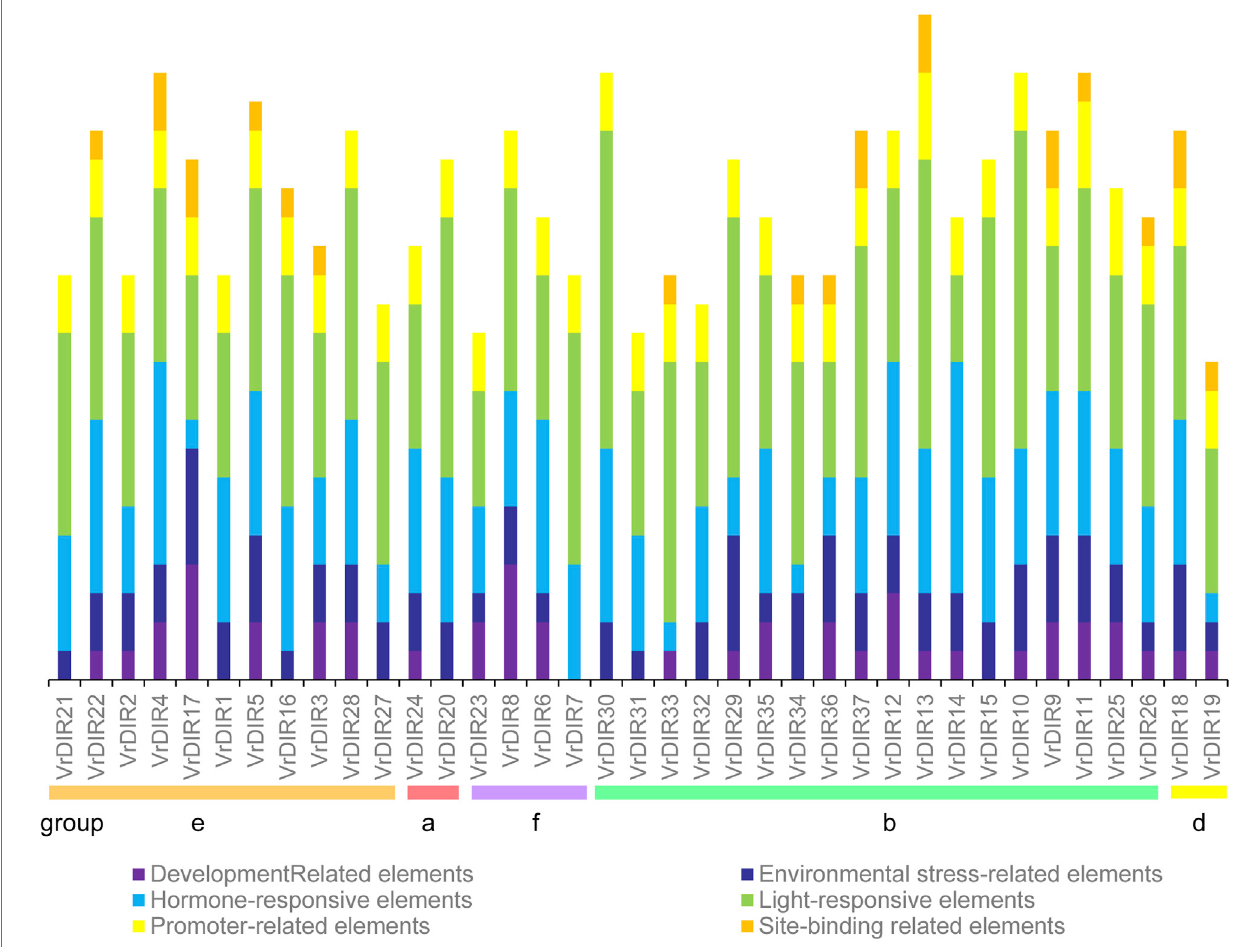
FIGURE 5 | Cis -acting element analysis in VrDIR promoter regions. The cis -acting elements were classi fi ed into six groups based on their predicted functions as described by Jin et al. (2019). Different cis -acting elements were presented using different colored boxes, and the Y-axis indicates the number of cis -acting elements in VrDIR